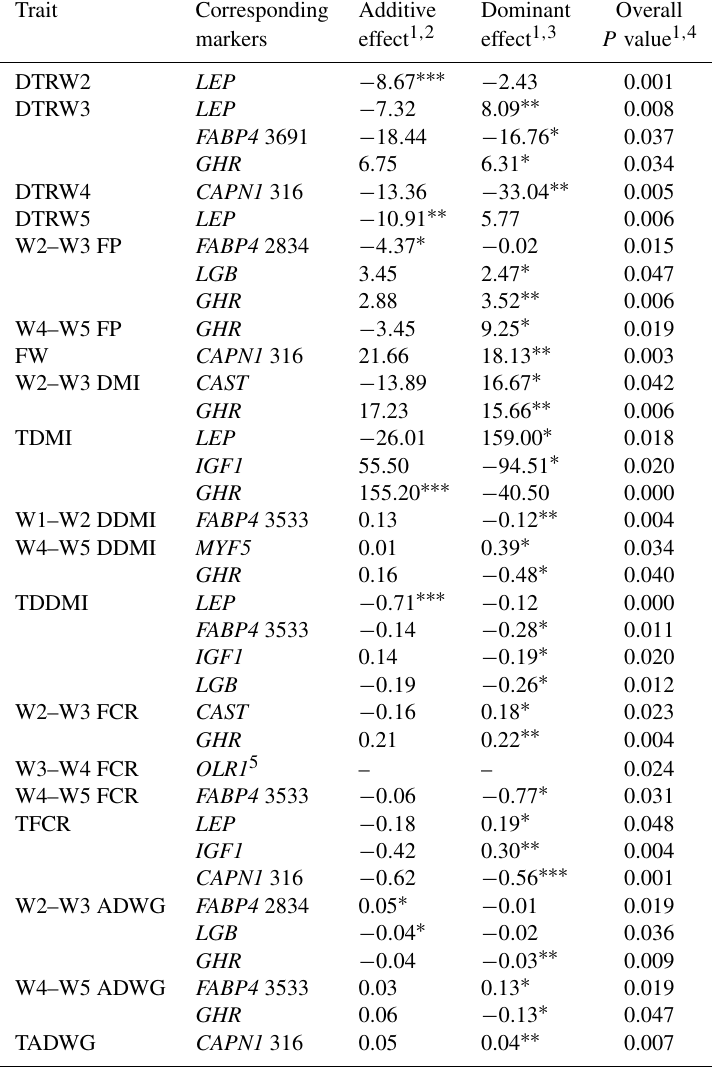
Table 8. Estimates of additive and dominance effects of the markers showing significant associations in the present